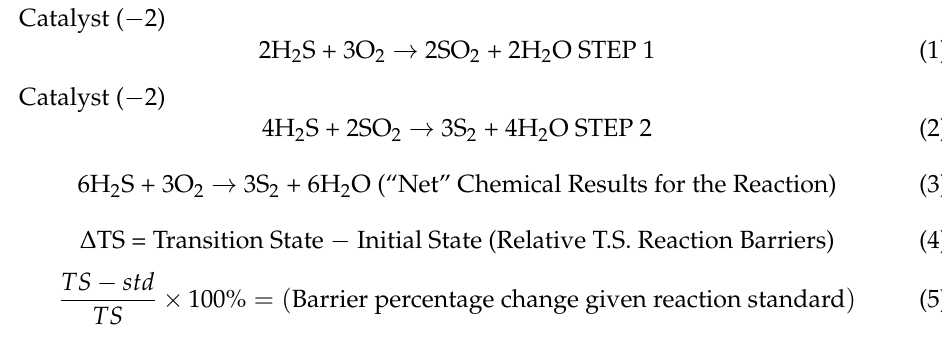
Figure 11. The step 4 of the final step of the sucrose conversion to organic honey. The enzyme catalase decomposes 2 molar hydrogen peroxide to 2 molar water and diatomic oxygen. The red and white spheres represent oxygen and hydrogen, respectively.